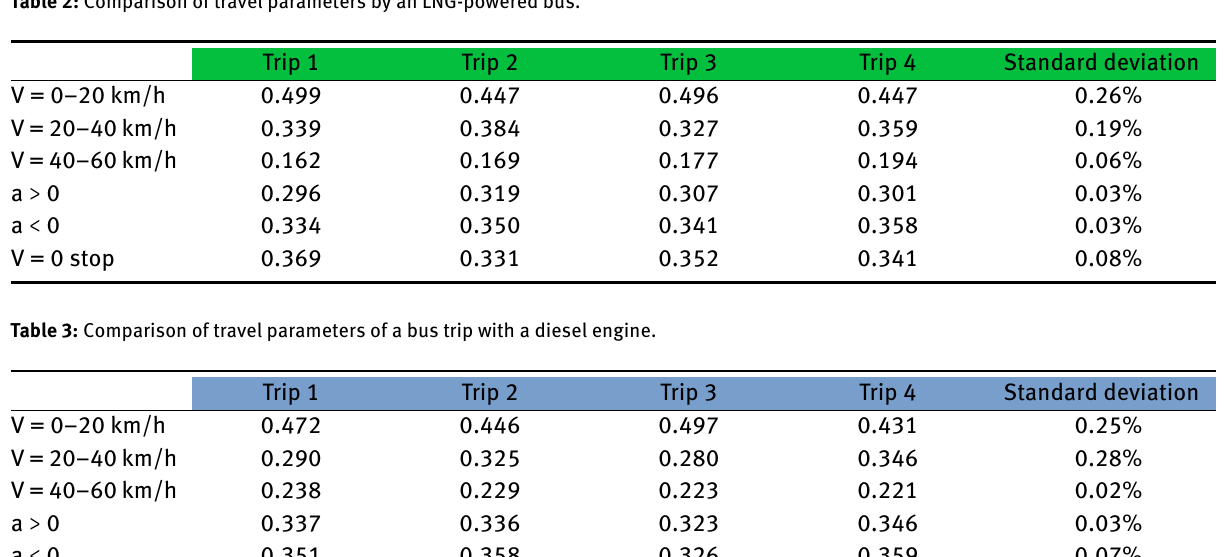
Table 2: Comparison of travel parameters by an LNG-powered bus.